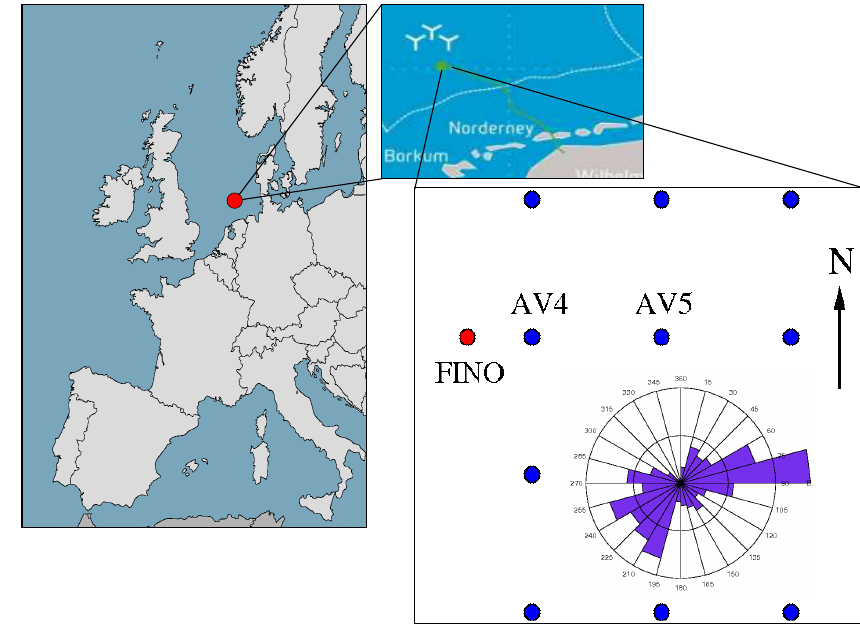
Figure 2. Sketch of the Alpha Ventus wind farm, located in the North Sea, near the northeastern coast of Germany. The study here described is based on measurements taken at the two wind turbines, AV4 and AV5, manufactured by Senvion SE (Hamburg, Germany). In the period of January 2013, during which the measurements analyzed in this paper were taken, the main wind direction is east-northeast.